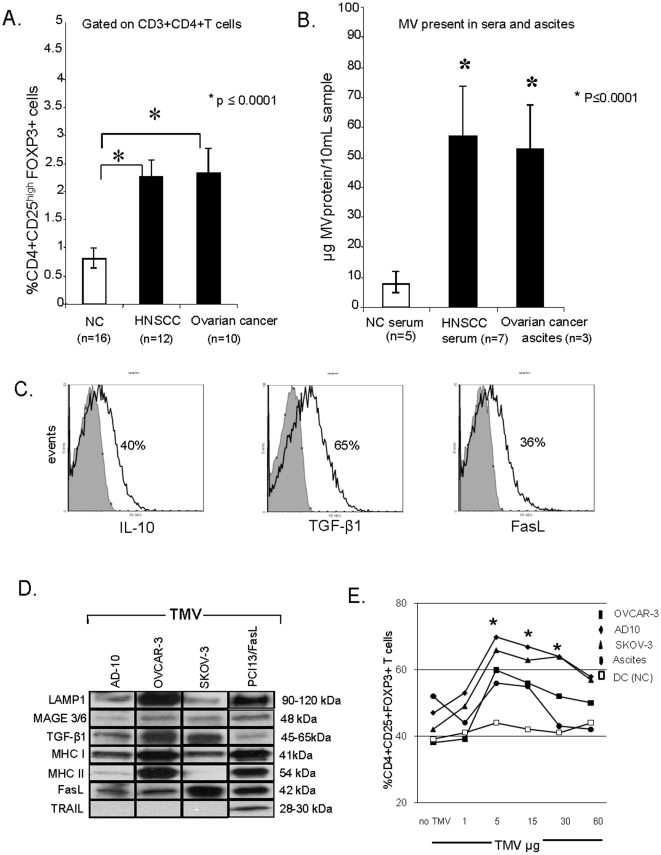
CD4+CD25highFOXP3+ T cells and microvesicles (MV) in cancer patients and normal controls (NC).(A) Percentages of CD4+CD25highFOXP3+ Treg in PBMC of cancer patients and NC. (B) the protein content/10 mL of serum or ascites in cancer patients and NC. The data in A and B are mean values ± SD. (C) Flow analyses of IL-10, TGF-β1 and FasL expression in MV purified from the ascites of OvCa patients and coated on latex beads. (D) Western blots of TMV isolated from OvCa SN. Molecular weights of the detected proteins are indicated. (E) Percentages of CD4+CD25+FOXP3+ cells in 8-day co-cultures of CD4+CD25neg T cells with TMV obtained from various sources and used at increasing concentrations. The asterisks indicate a significant increase at p<0.05.